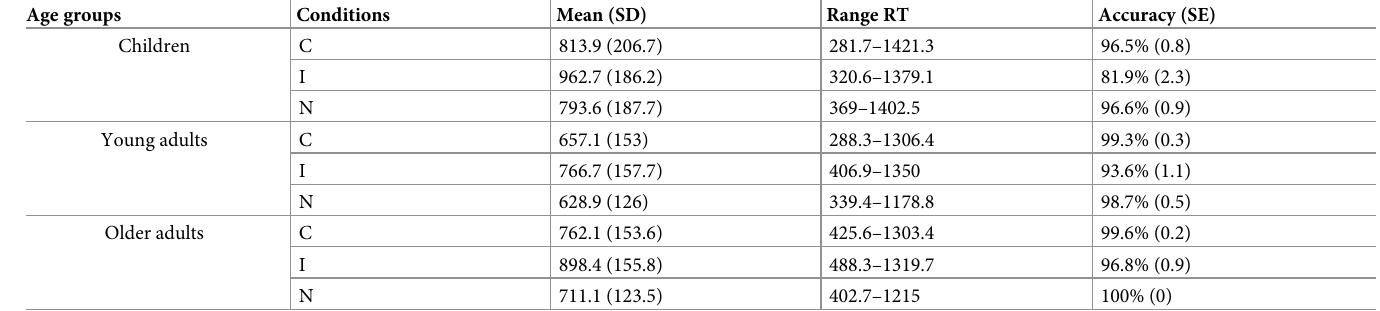
Table 1. Descriptive statistics regarding the mean latencies with their relative standard deviations, the range between the minimum and maximum reaction times observed and accuracy with its standard error. Age